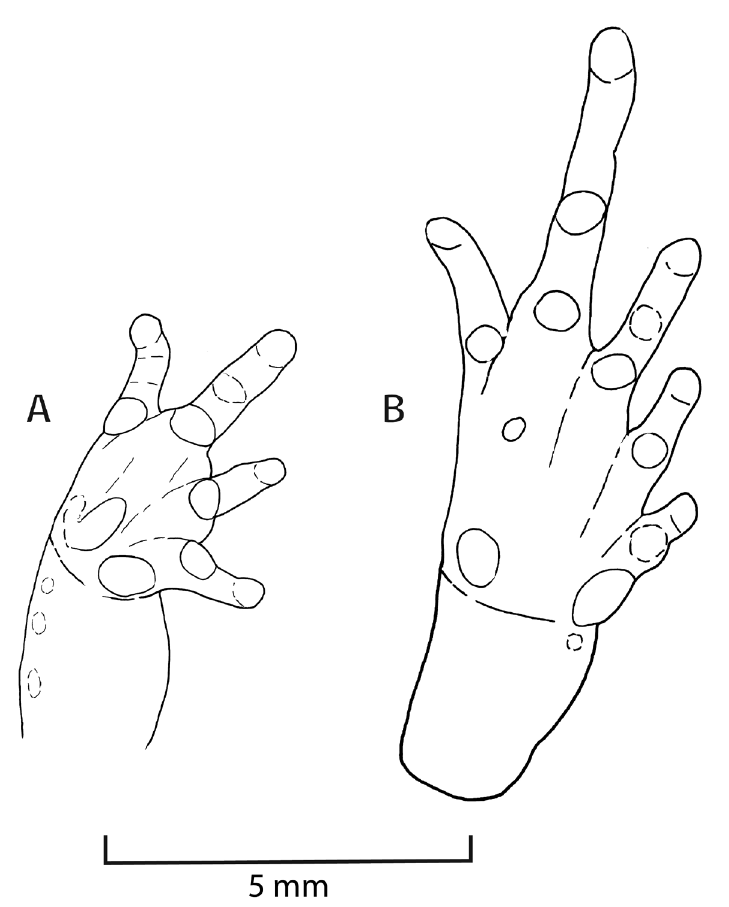
Figure 4. Ventral views of right hand ( A ) and right foot ( B ) of holotype of Pristimantis attenboroughi sp. n. (MUSM 31196). Drawings by E.